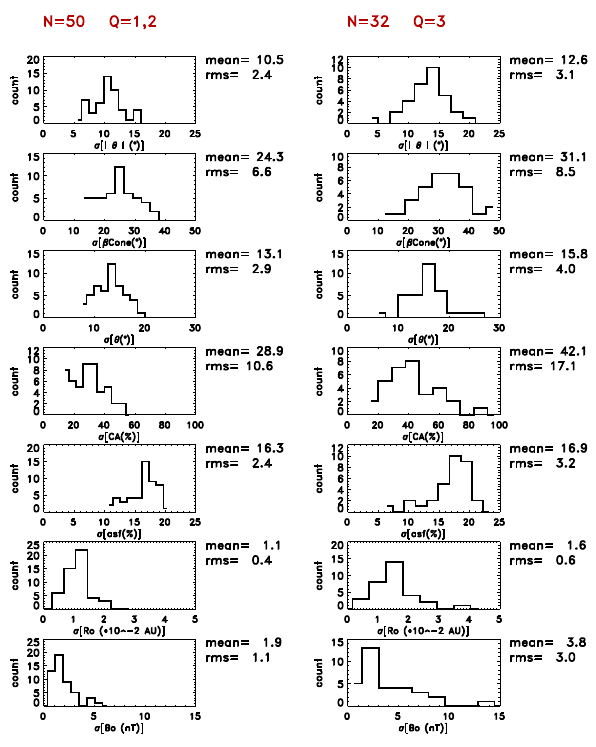
Fig. 13. Histograms of the uncertainties ( σ s) for various MC pa- rameters (in the order | θ A | , β CA , θ A, CA (=Y 0 /R 0 , in %), asf(in %), R 0 , and B 0 ) , where the combined Q 0 =1,2 cases (N=50) are in the first column and the Q 0 =3 cases (N=32) are in the second col- umn, as noted. For any given case the designations of mean and rms hold for the specific histogram shown to their left, and they have the same units as that histogram, as shown below it. An rms for a given histogram provides a measure of the spread in the parameter uncer- tainties across a particular set of MCs; as expected, the Q 0 =3 cases show larger rmss than the Q 0 =1,2 cases.